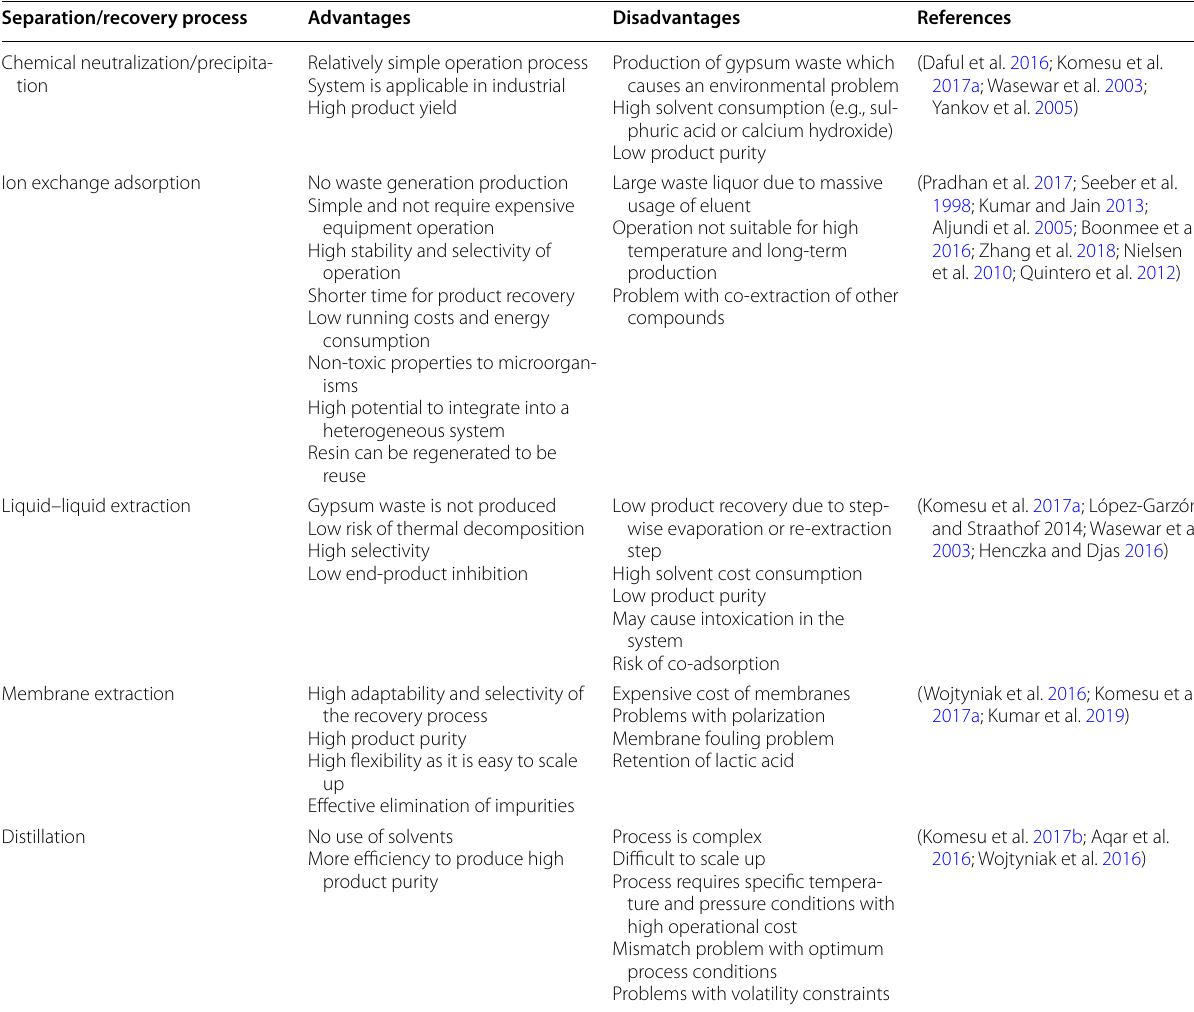
Table 2 Summary of lactic acid separation and recovery process Separation/recovery